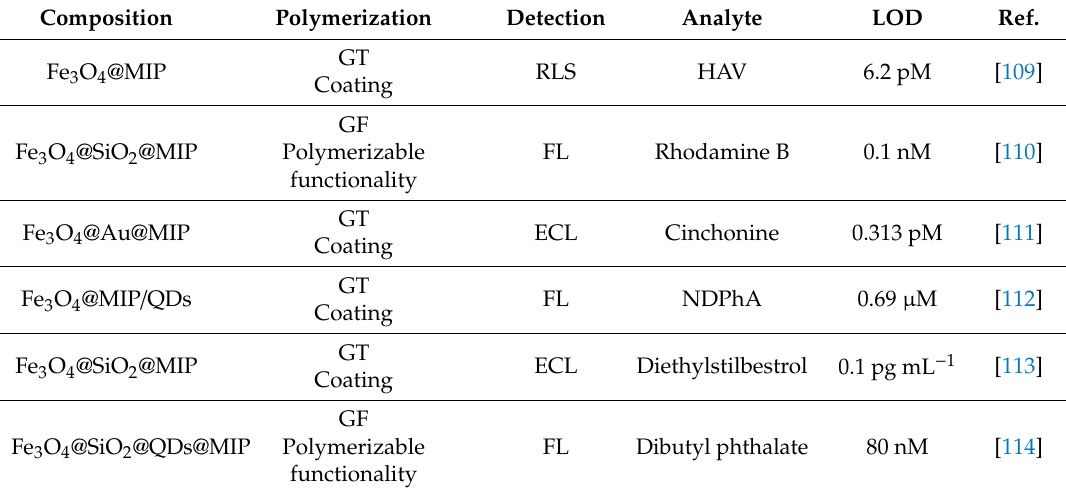
Table 5. Optical sensors based on core-shell MIPs with a magnetic core.